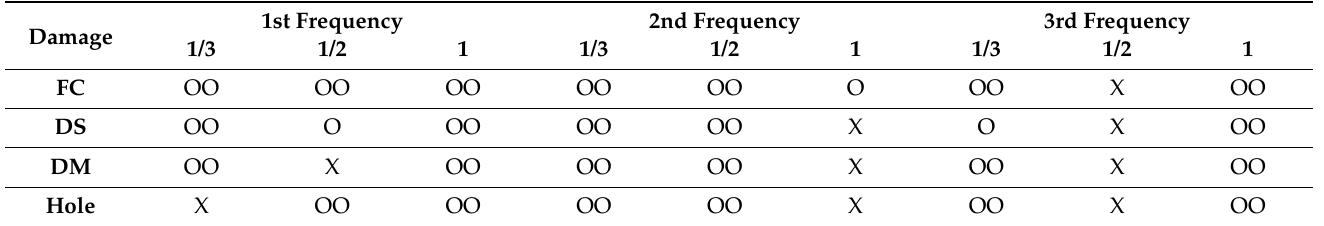
Table 4. Summary for PVDF (X: not sensitive (0 or 1 sub- or super-harmonic); O: sensitive (2 sub- or super-harmonics); OO: very sensitive (>2 sub- or super-harmonics)).